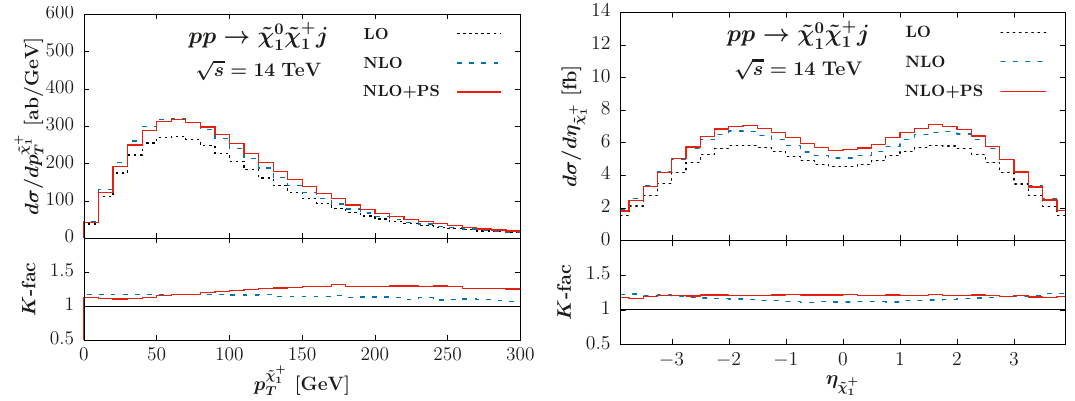
Figure 8 . Angular separation (cid:30) between the missing momentum ~p miss and the hardest jet momen- tum ~p jet vectors (left) and missing transverse momentum p miss 1 at LO (dotted black lines), NLO (dashed blue lines) and NLO+PS (solid red lines), after the cuts of eqs. (3.6) are applied.